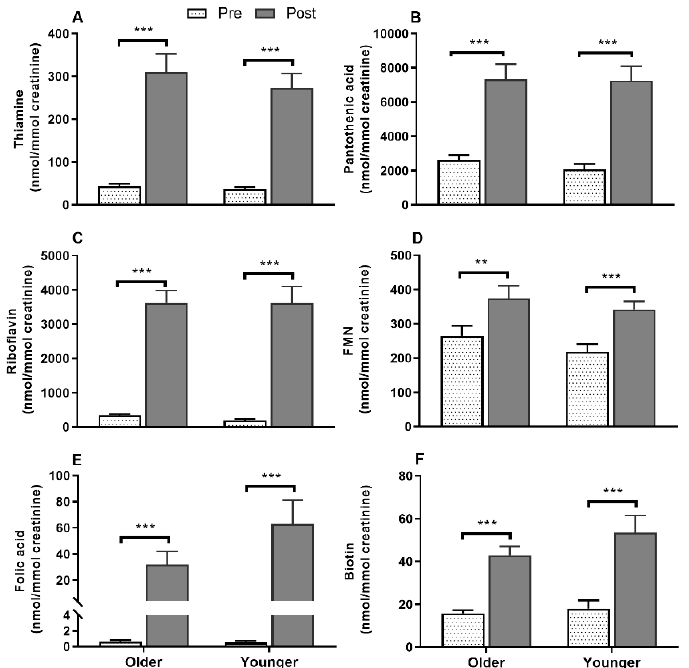
Figure 6. Urinary concentrations of ( A ) thiamine, ( B) , pantothenic acid ( C ), riboflavin, the vitamer ( D ), flavin mononucleotide (FMN), ( E ) folic acid, and ( F ), biotin following supplement ingestion in older and younger adults. Bar plots and error bars represent means and ± SEM respectively, n = 20 in each age groups and concentrations were normalized for urinary creatinine (nmol/mmol creatinine). Data for pre and post supplement ingestion was compared using generalized linear repeated measures analysis of variance with time as within subject and age as between subject factor. Sidak post hoc test was applied for pairwise comparisons in case of an interaction. There were no interactions between any independent factors (age and time). There were main time effects (**, p < 0.01; ***, p < 0.001) for all the vitamins.